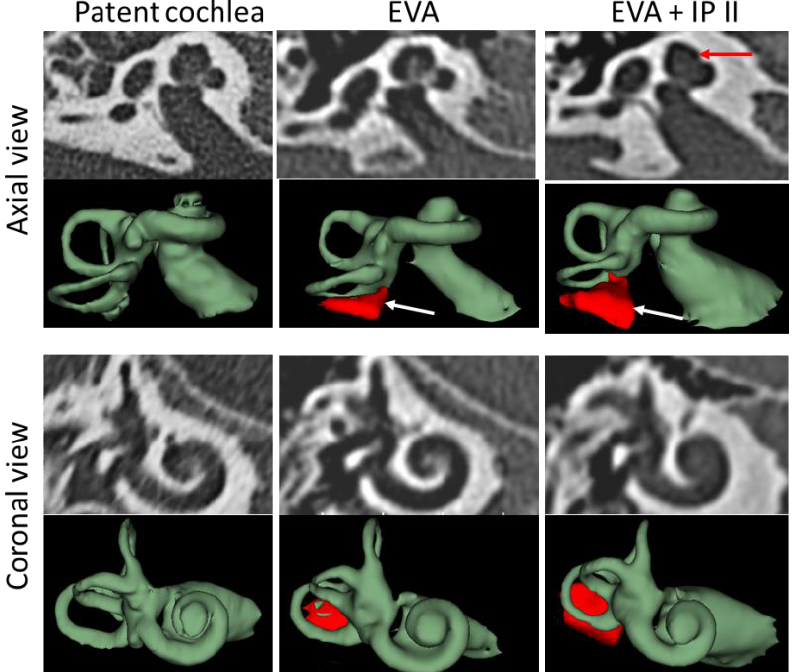
Figure 1. Visualisation of different cochlear anatomies. The red arrow in the EVA + IP II column points to the cystic apex. The white arrows in the second row point to the enlarged vestibular aqueducts.